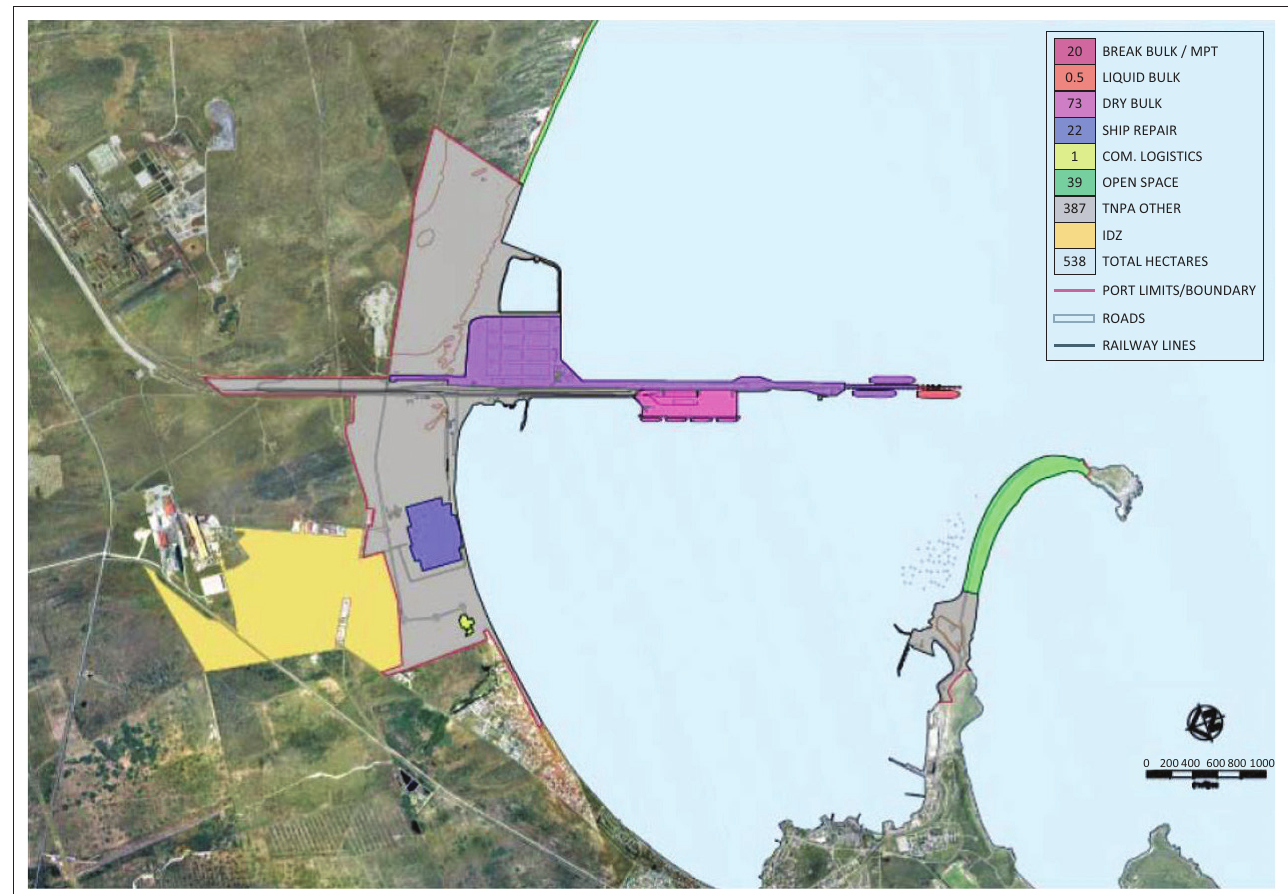
FIGURE 2: Current layout of Transnet Saldanha Bay